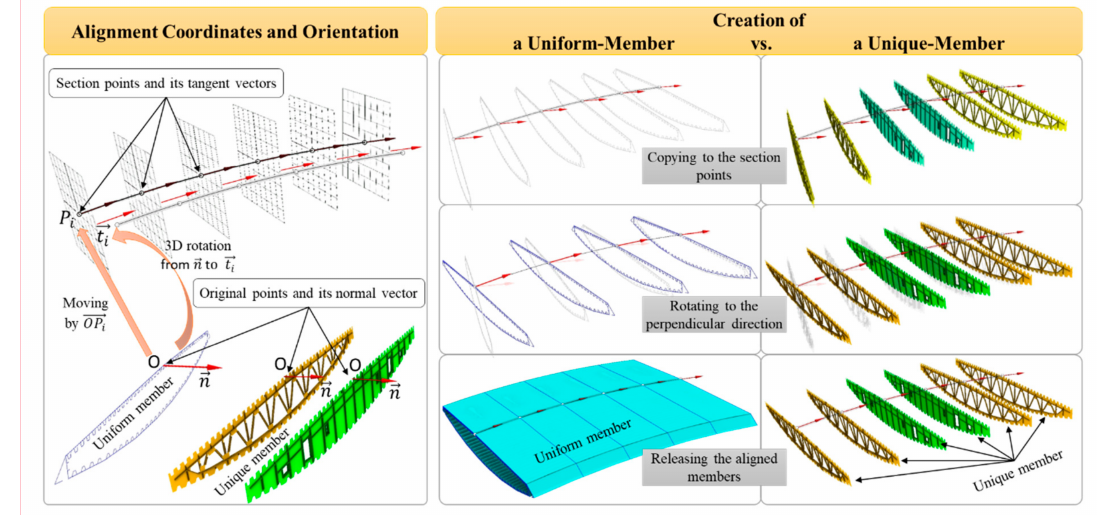
Figure 8. Alignment-based algorithm for the slender section of a sti ff ening girder.